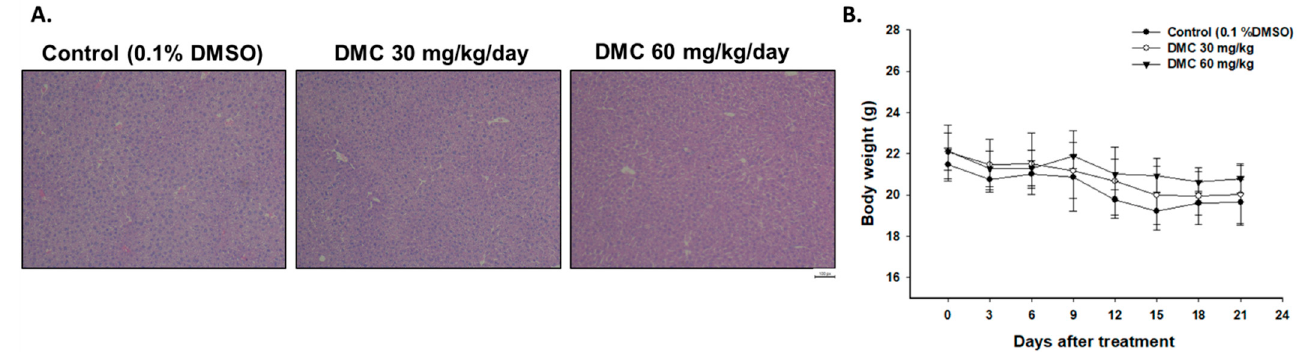
Figure 4. No acute or delayed toxicity was found in DMC-treated glioblastoma-bearing mice. ( A ) Liver pathology photograph from the microscope with 100 times magnification. ( B ) Mouse body weight was measured and recorded every three days.